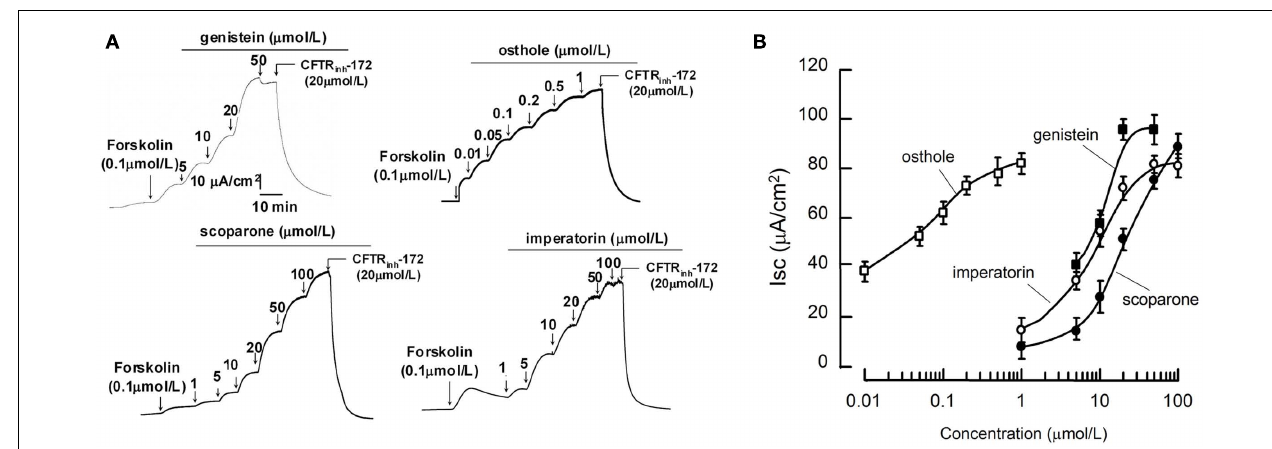
presence of a 60-mmol/L basolateral to apical transepithelial Cl − gradient. Where indicated, various concentrations of the compounds were added to the apical chamber solutions. (B) Dose–response analysis indicates that the natural coumarins stimulated Cl − currents in a concentration-dependent manner. (mean ± SE, n =